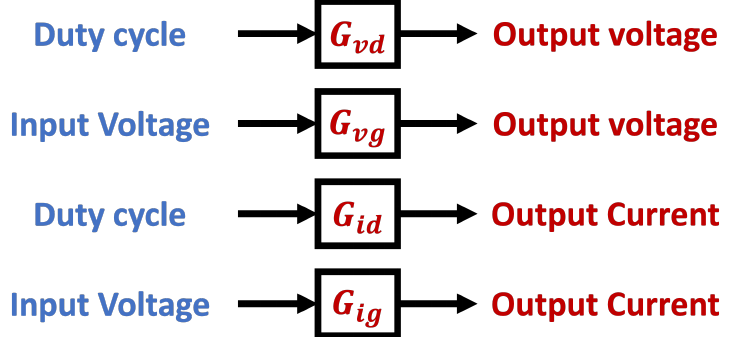
Figure 10. Input/output block diagram exemplification for each small-signal transfer function for DC–DC